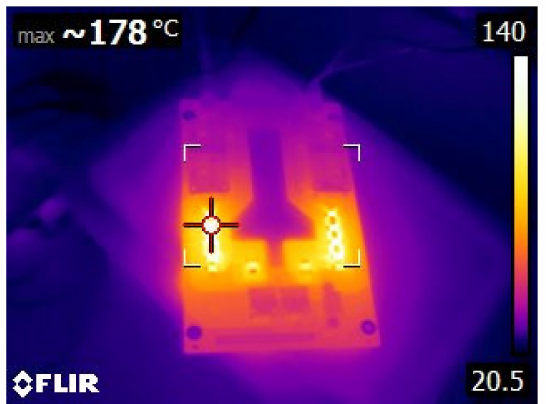
Figure 12. Detailed thermograph of an integrated circuit before the installation of the heat